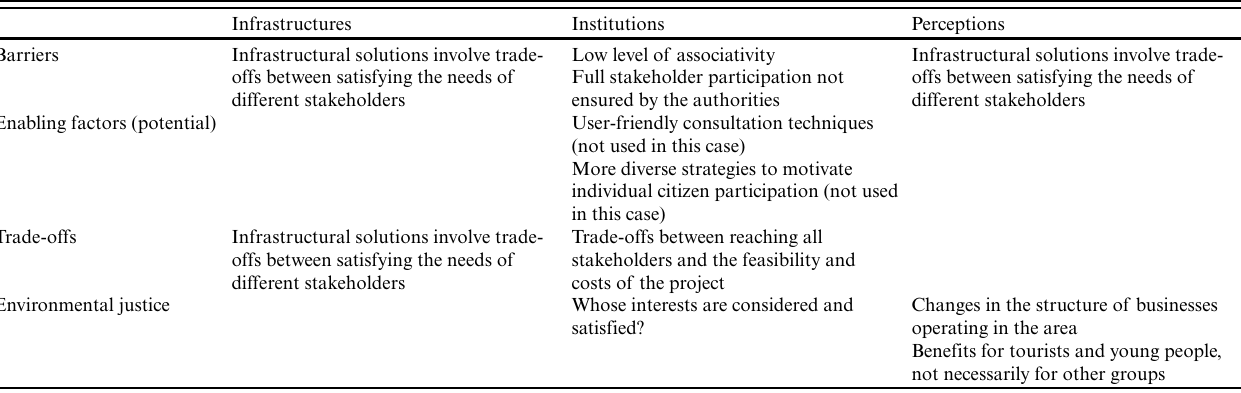
Table 4. ENABLE filters mediating the flow of benefits from GBI to potential beneficiaries translated into an analytical framework for the assessment of GBI-related initiatives—in the case of renewal of Passeig de Sant Joan in